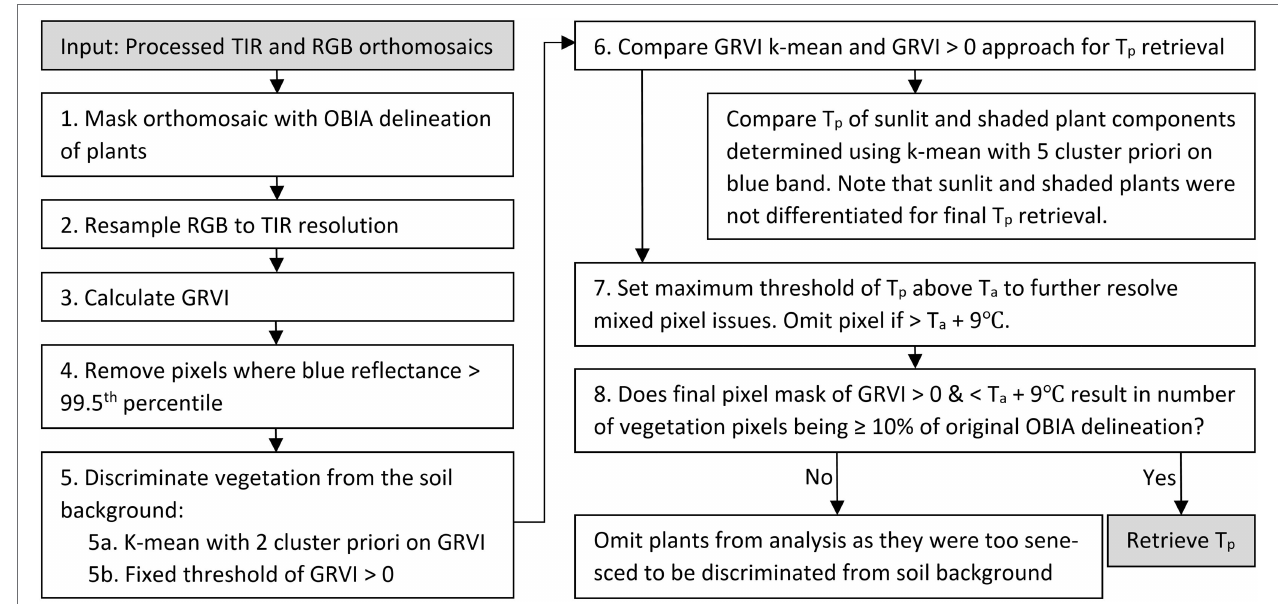
FIGURE 2 | Workflow to retrieve plant temperature (T p ) of green vegetation from the thermal infrared (TIR) orthomosaic using an object-based image analysis (OBIA) delineation of the red, green, and blue (RGB) image data, k-mean classification, green–red vegetation index (GRVI) thresholding, and air temperature (T a